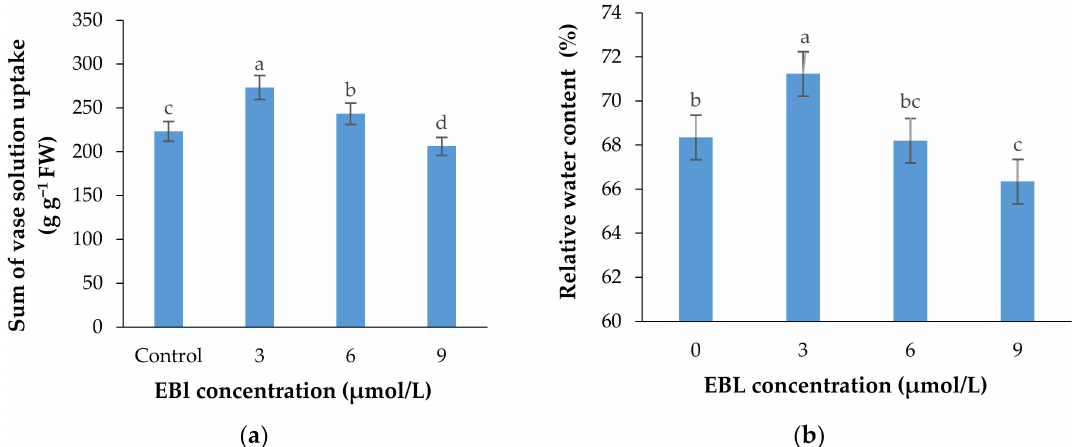
Figure 7. Sum of the vase solution absorbed by each lisianthus cut flower (mean of four replicates) ( a ) and the relative water content of the flowers ( b ) as affected by the EBL treatment at different concentrations. Error bars represent the standard error of means of four replicates. Columns indicated by different letters are significantly different according to Duncan’s multiple range test ( p ≤ 0.01).